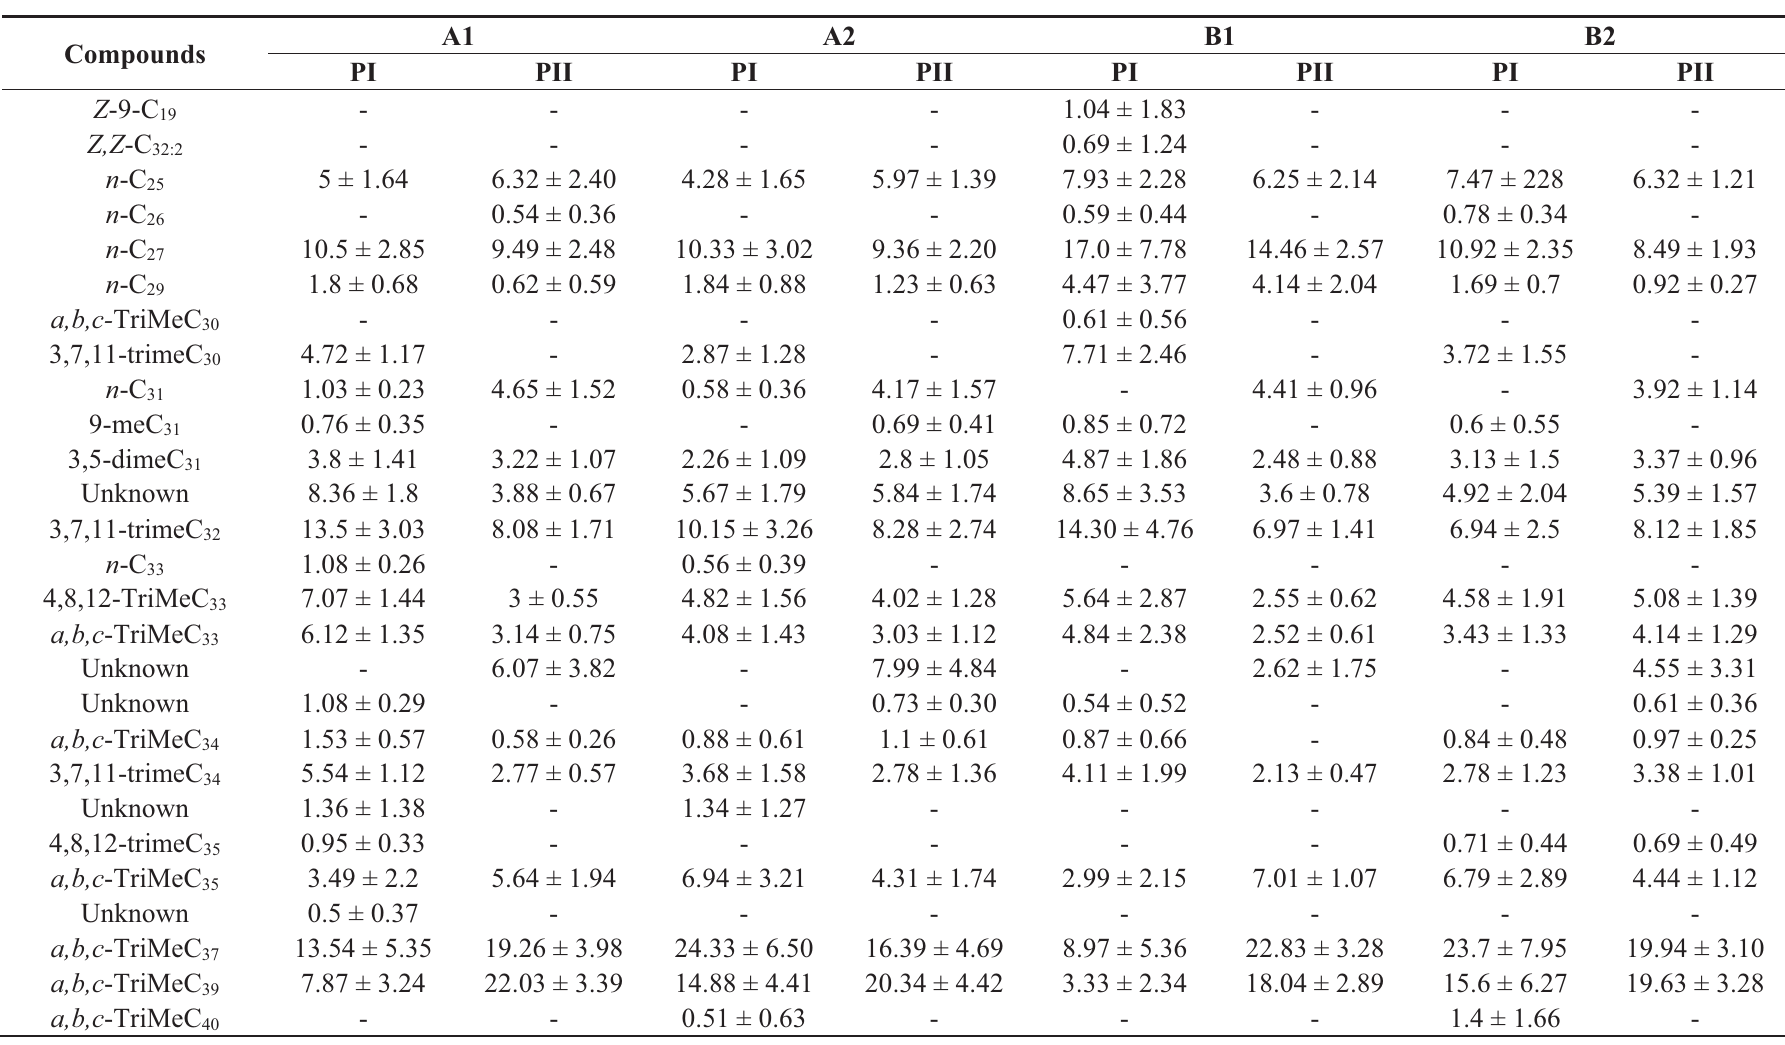
Table 1. Mean and standard deviation of the relative proportions of cuticular hydrocarbons of four Atta sexdens colonies (A1, A2, B1 and B2) at both experimental phases (PI-I phase; PII